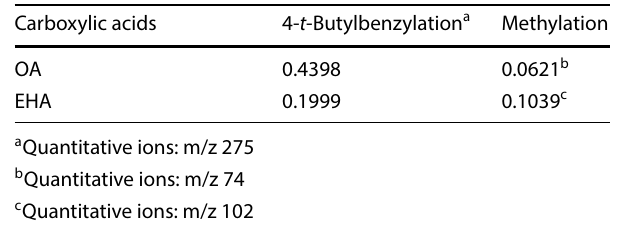
Table 6 Comparison of the peak area ratios of 4- t -butylbenzyl derivatives with those of methyl derivatives